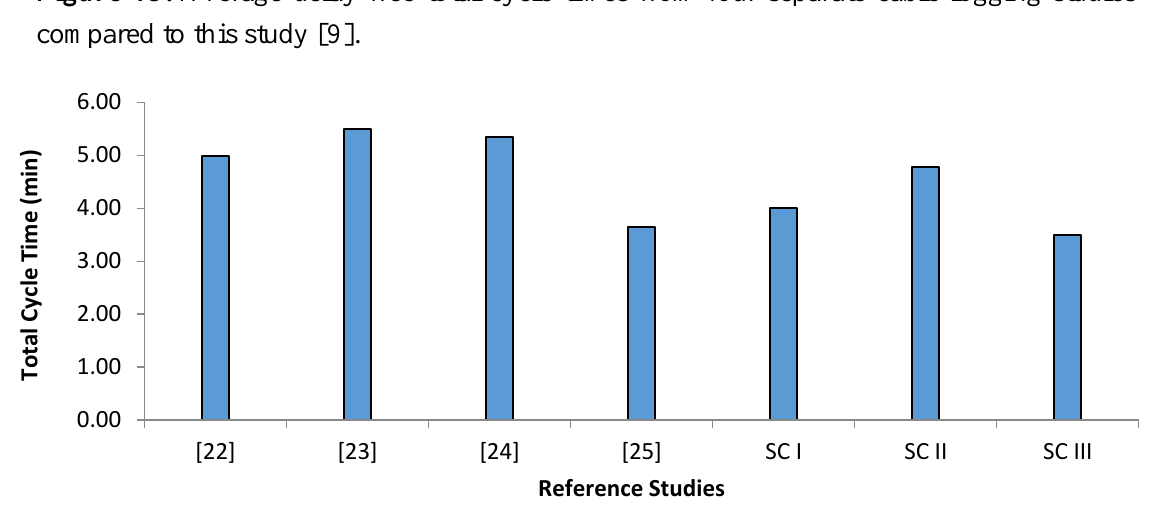
Figure 13. Average delay free total cycle times from four separate cable logging studies compared to this study